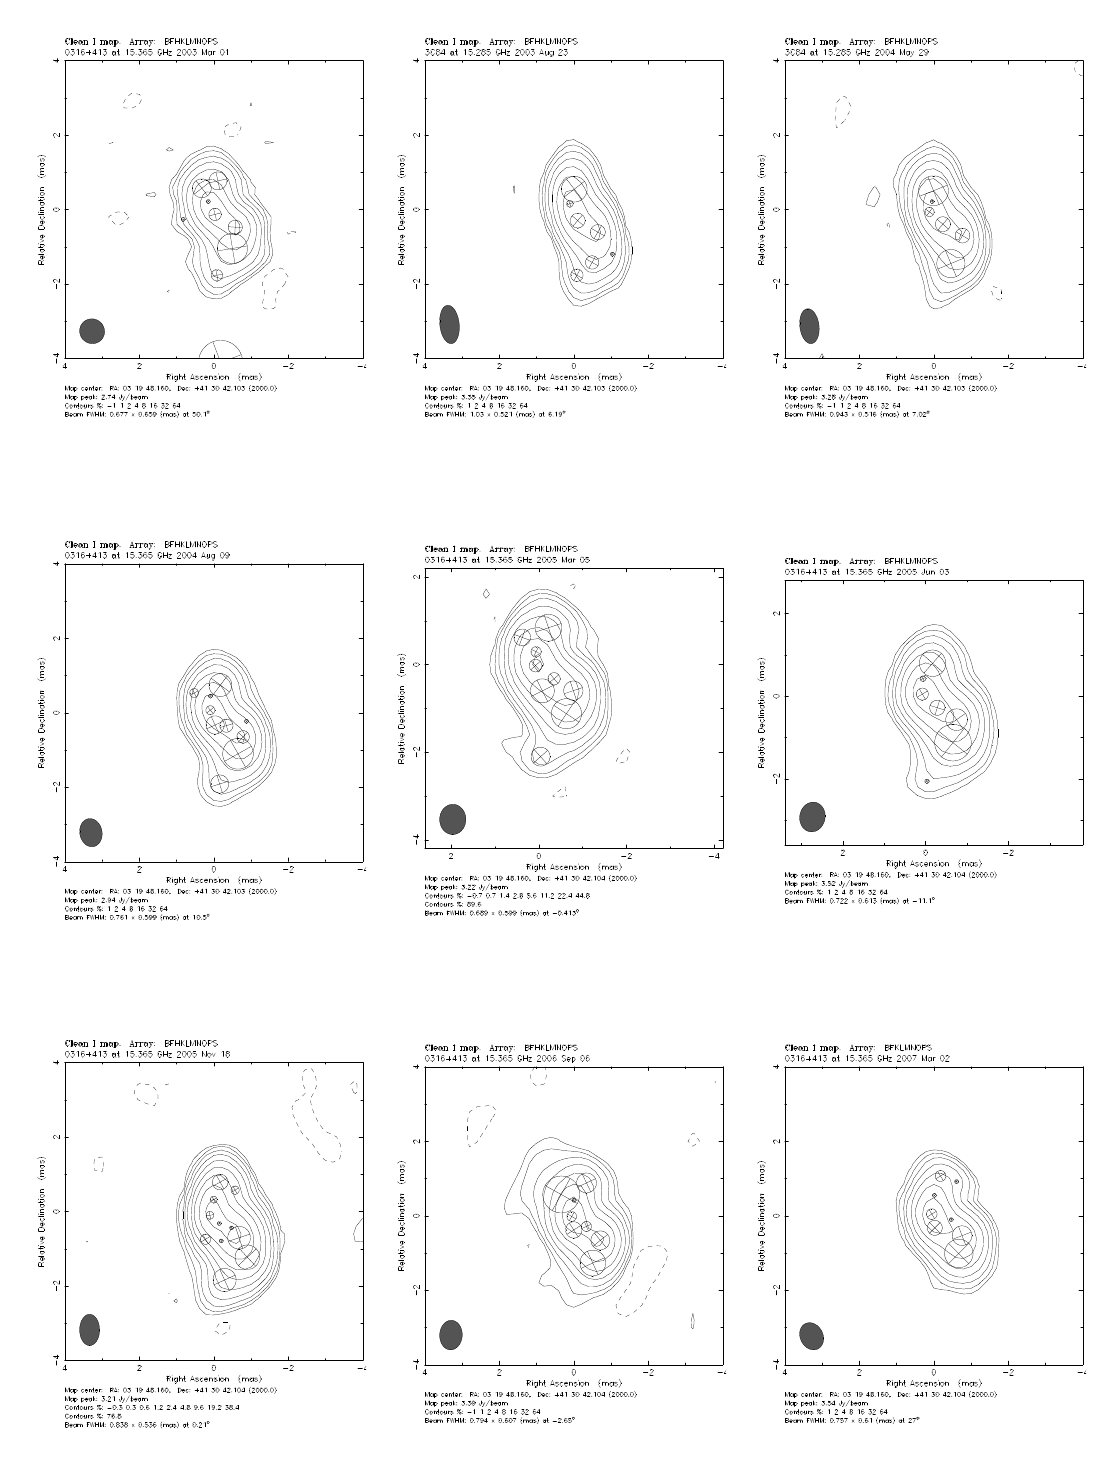
Figure A2. Same as Figure A1 for epochs: March 2003—March